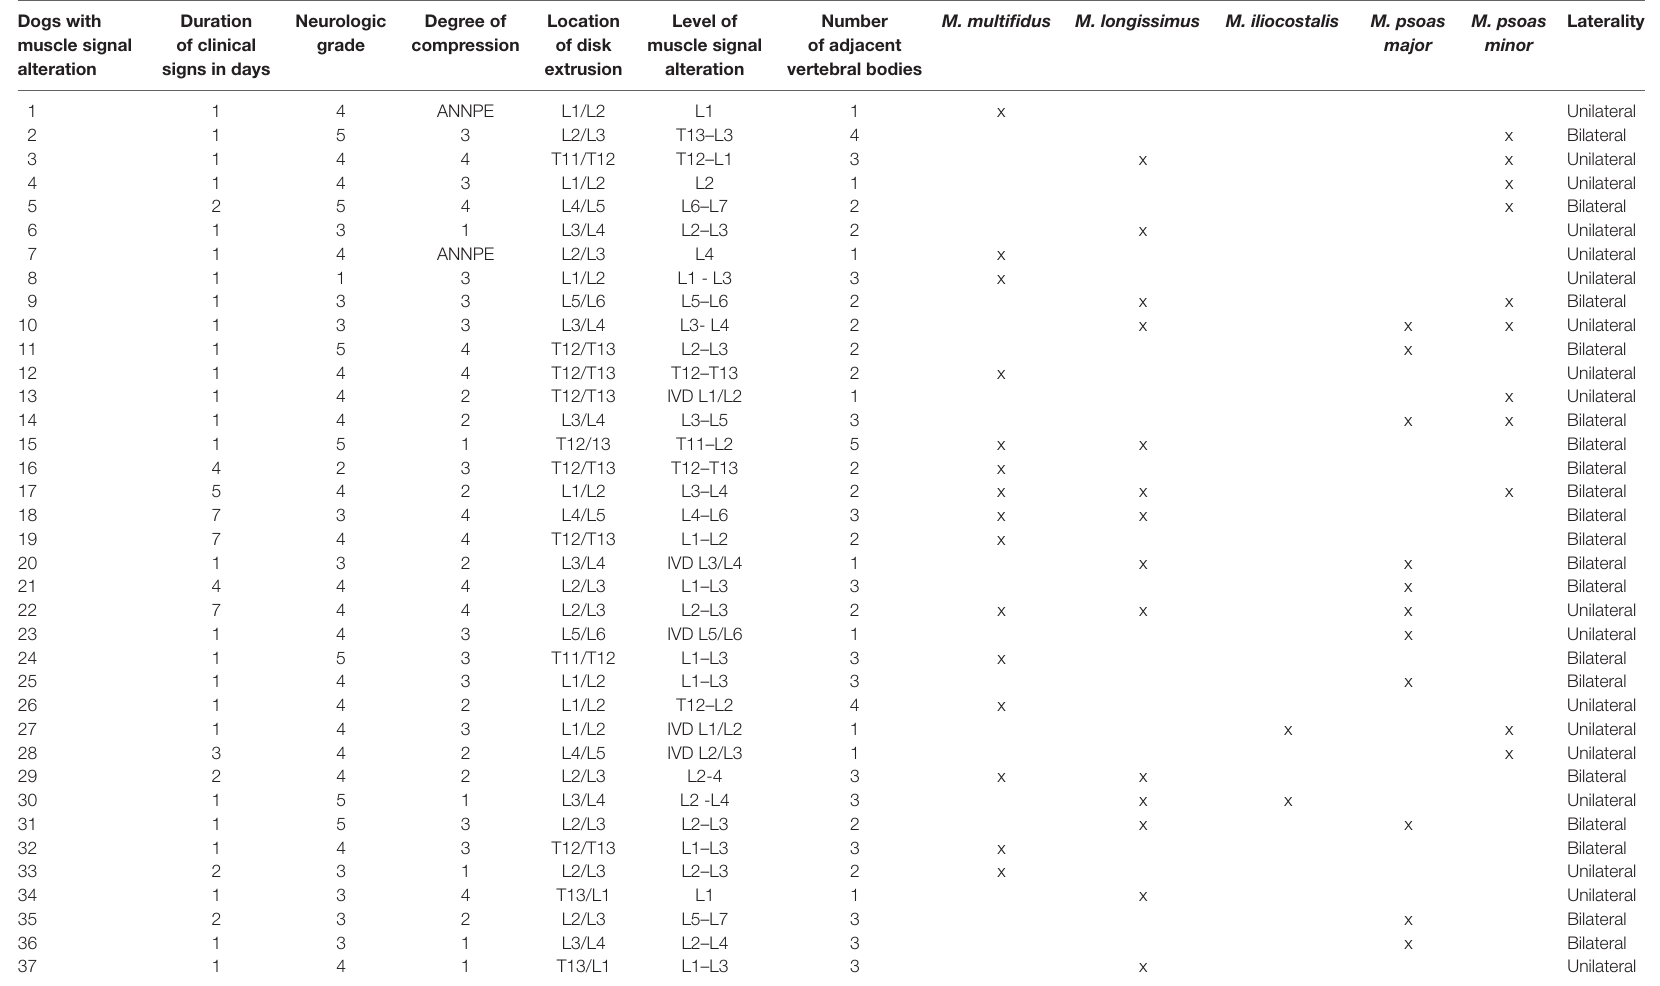
TaBle 1 | List of all dogs with muscle signal alteration with the duration of their clinical signs, neurologic grade, degree of compression, location of disk extrusion, level of muscle signal alteration in the vertebral column, number of adjacent vertebral bodies, affected muscles, and laterality. Dogs with muscle signal